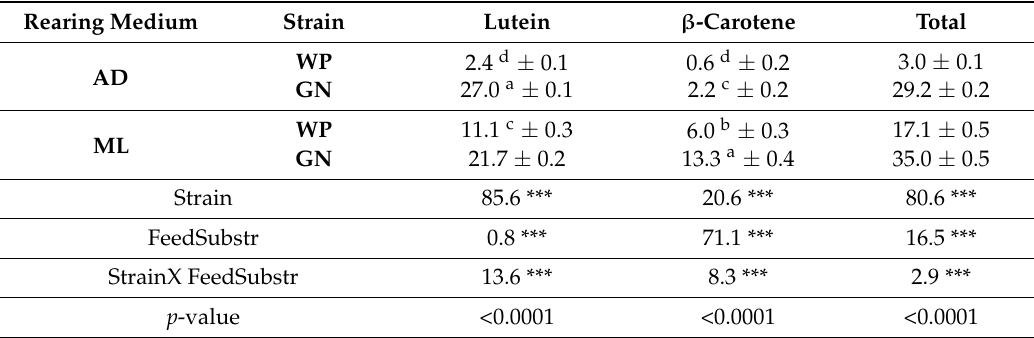
Table 4. Carotenoids content ( µ g/gr pupae) of White Polyhybrid (WP) and Golden Nistari (GN) strains fed an artificial diet (AD) and mulberry leaves